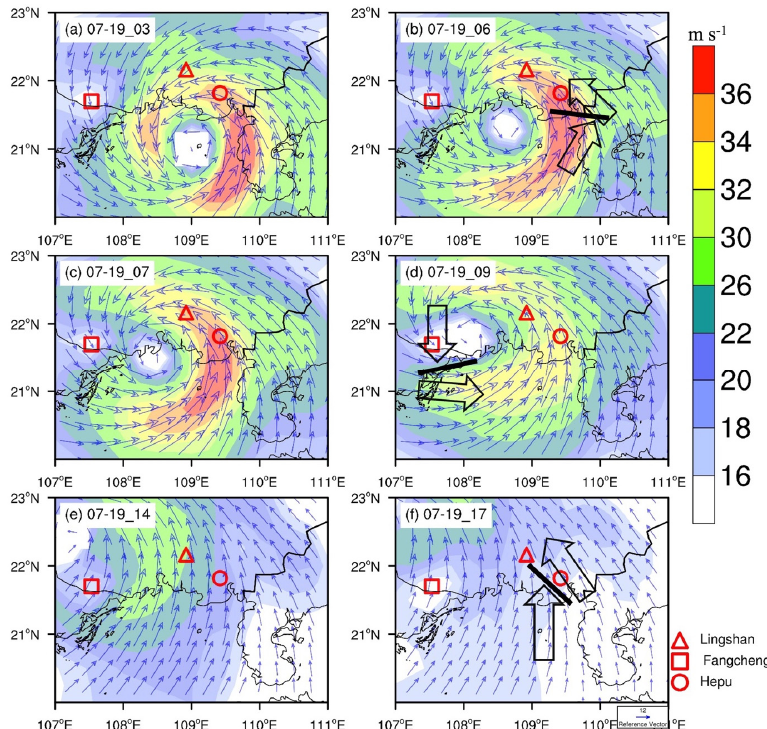
Figure 5. The geographic distributions of the 925 hPa wind (vectors and shadings, 16 m s − 1 ) and divergence (contours, 10 − 5 s − 1 ) from ERA5 at onset and peak for Hepu ( a , b ), Fangcheng ( c , d ), and Lingshan ( e , f ) rainstorms, with the red markers and black lines denoting the rainstorm centers and convergence